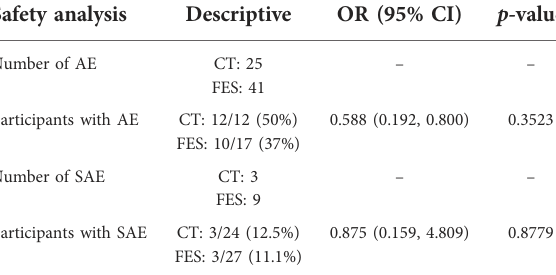
TABLE 11 COVID subgroup analysis using multiple